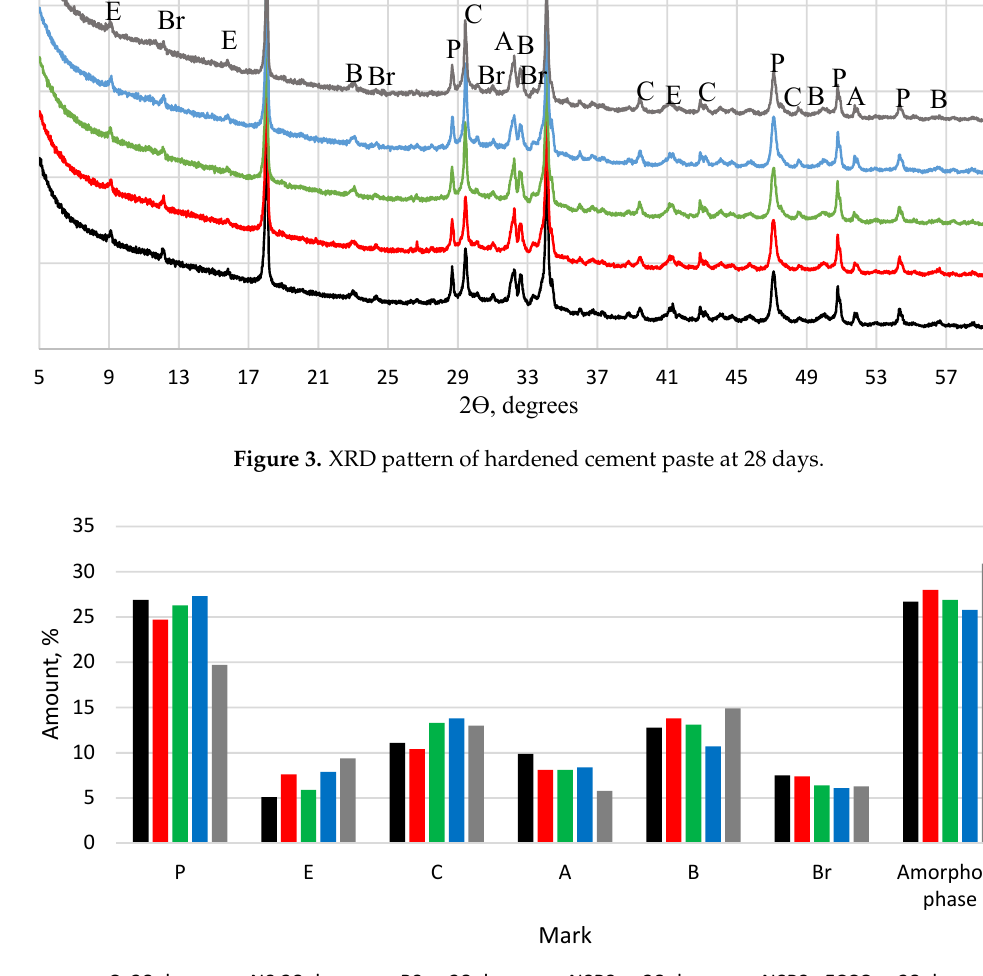
Figure 4. The comparison of the amount of minerals and amorphous phase at 28 days.